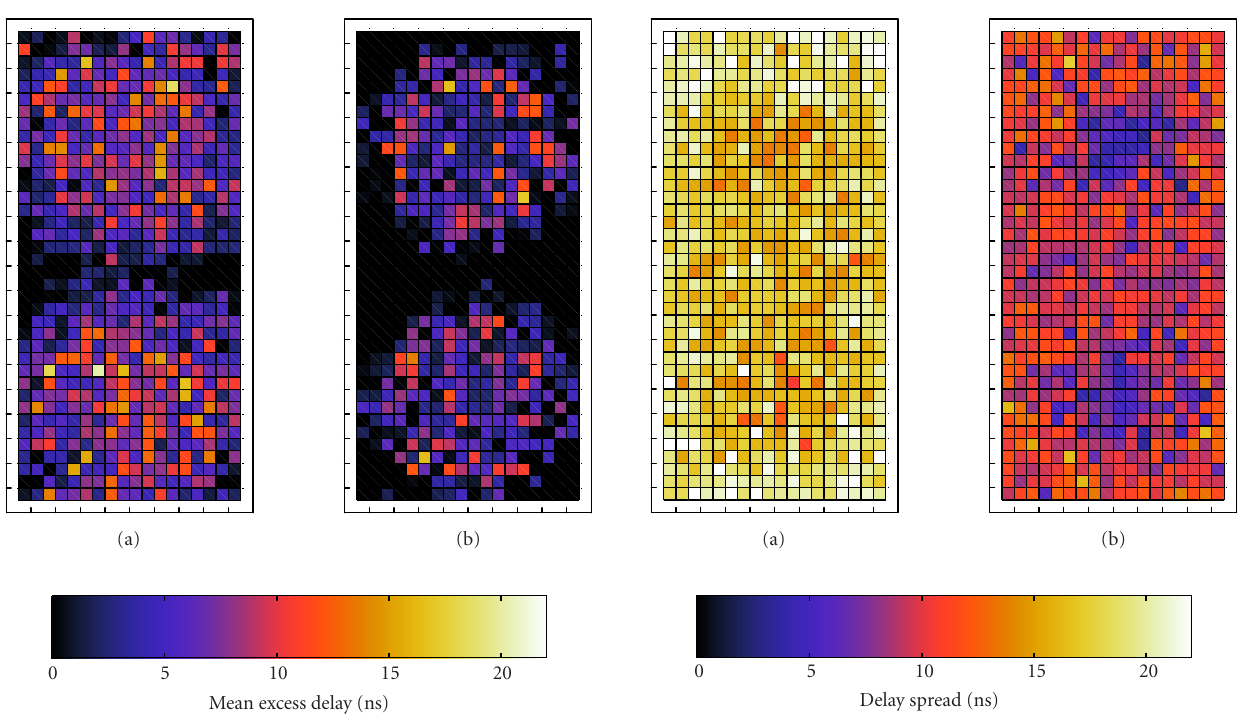
Figure 6: Simulated delay spread of channel using parameters in Table 1. (a) Omnidirectional. (b) w/ beam pattern.